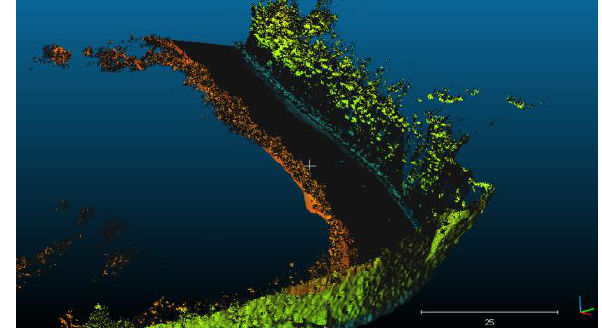
Figure 7. Point cloud of the urban road in Vigo.